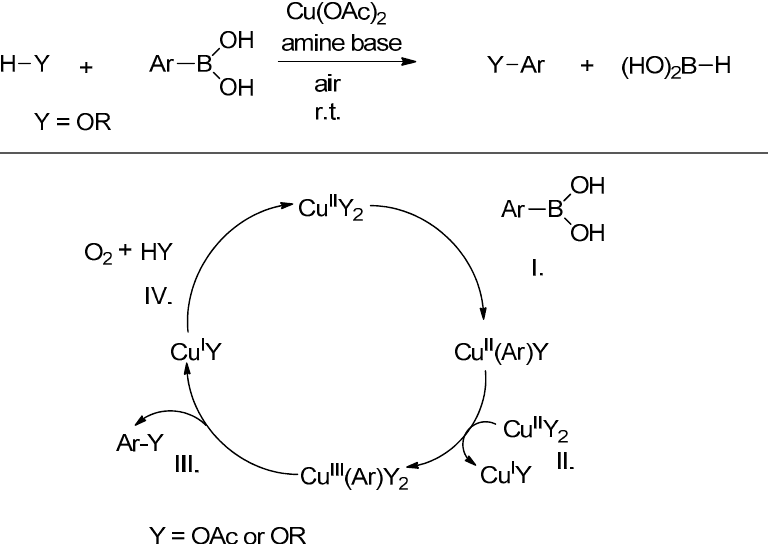
Figure 1. Chan–Lam coupling: C ‒ O bond formation and its proposed mechanism [13].